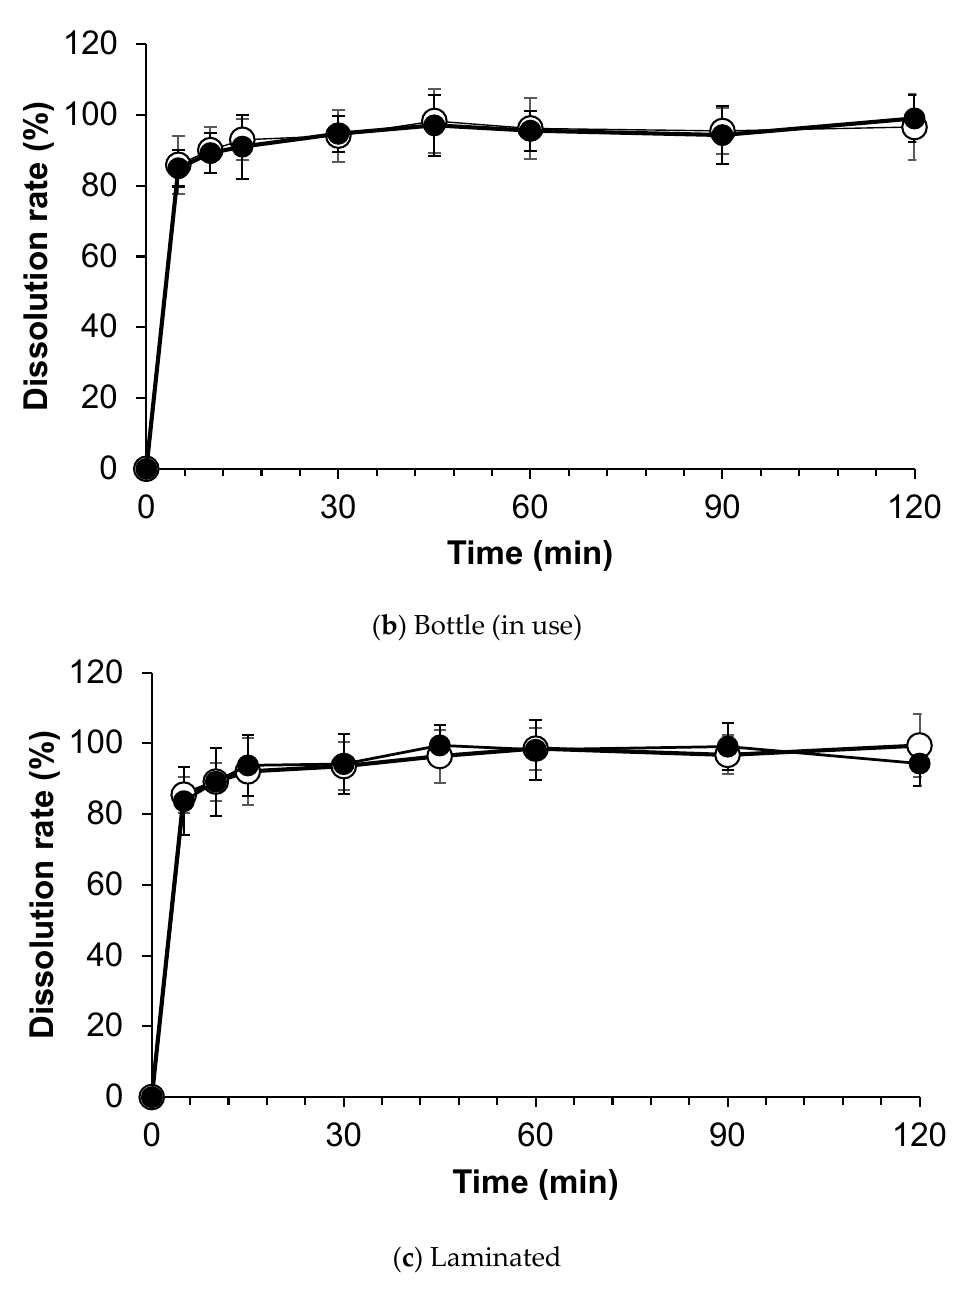
Figure 4. Dissolution profiles of compounded baclofen formula in water on days 0 (closed circles) and 120 (opened circles) in each condition. Each sample was examined in six replicates.